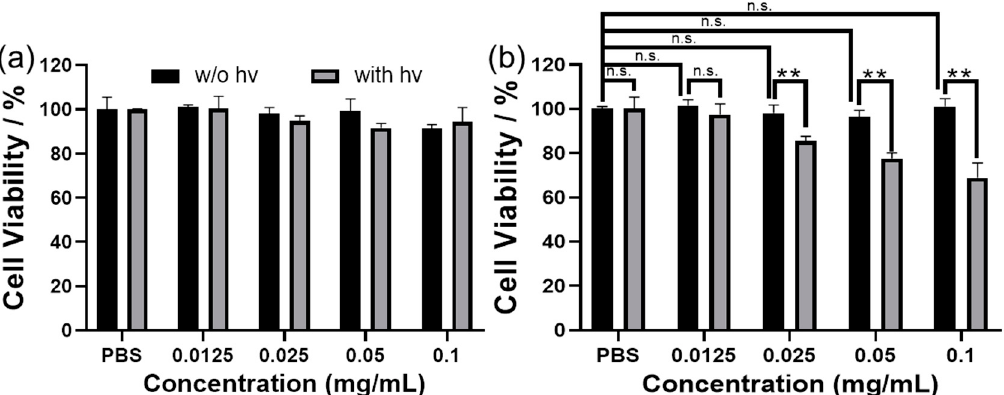
Figure 5. Cell viability of ( a ) L929 and ( b ) HeLa at different PCOFA micelle concentrations (0.0125 mg/mL, 0.025 mg/mL, 0.05 mg/mL, 0.1 mg/mL) without DOX with or without 410 nm irradiation (28 mW/cm 2 ) for 20 min after 24 h incubation. Data are presented as mean ± s.d. ( n = 3); n.s., not significant; p values were calculated in comparison with the non-irradiated groups. ** p < 0.01.